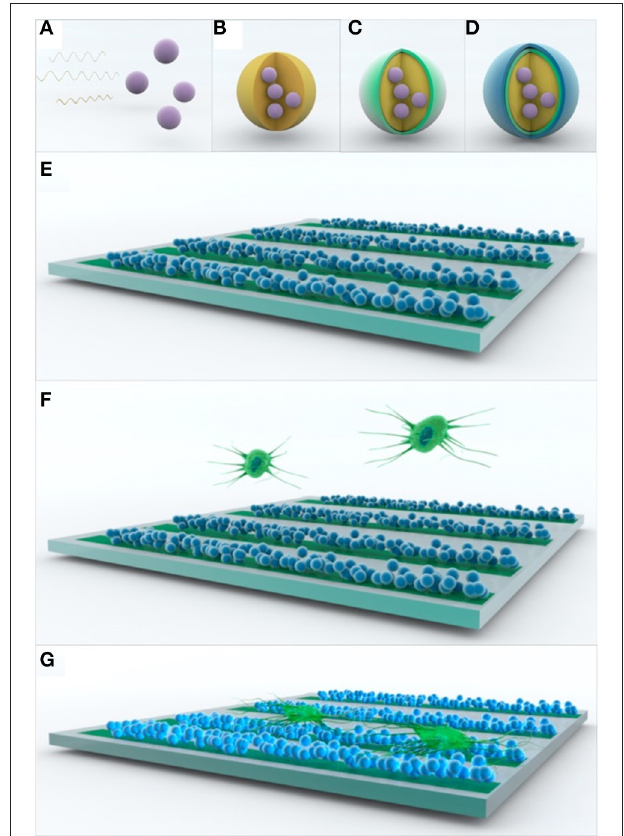
FIGURE 9 | Scheme of the assembly of multifunctional PEDOT:PSS nanoparticle arrays for ES. (A–D) Multilayer formation of PEDOT:PSS nanoparticles via non-spontaneous emulsification. (E–G) Patterning of the multilayered PEDOT:PSS nanoparticles for ES of PC12 cells. Reproduced from ( 108) with permission from the